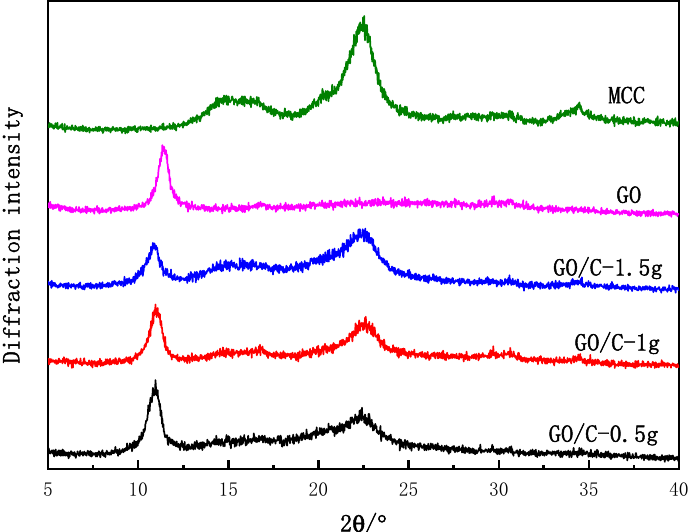
Figure 2. The XRD spectra of microcrystalline cellulose (MCC), graphene oxide (GO), GO plus 0.5 g MCC composite (GO/C-0.5 g), GO plus 1 g MCC composite (GO/C-1 g), and GO plus 1.5 g MCC composite (GO/C-1.5 g).